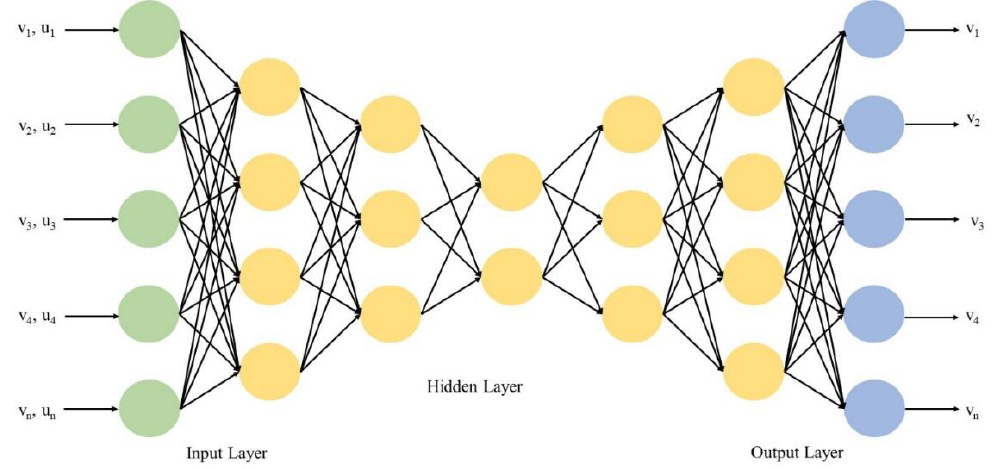
Figure 3. Fully connected layer in CNN